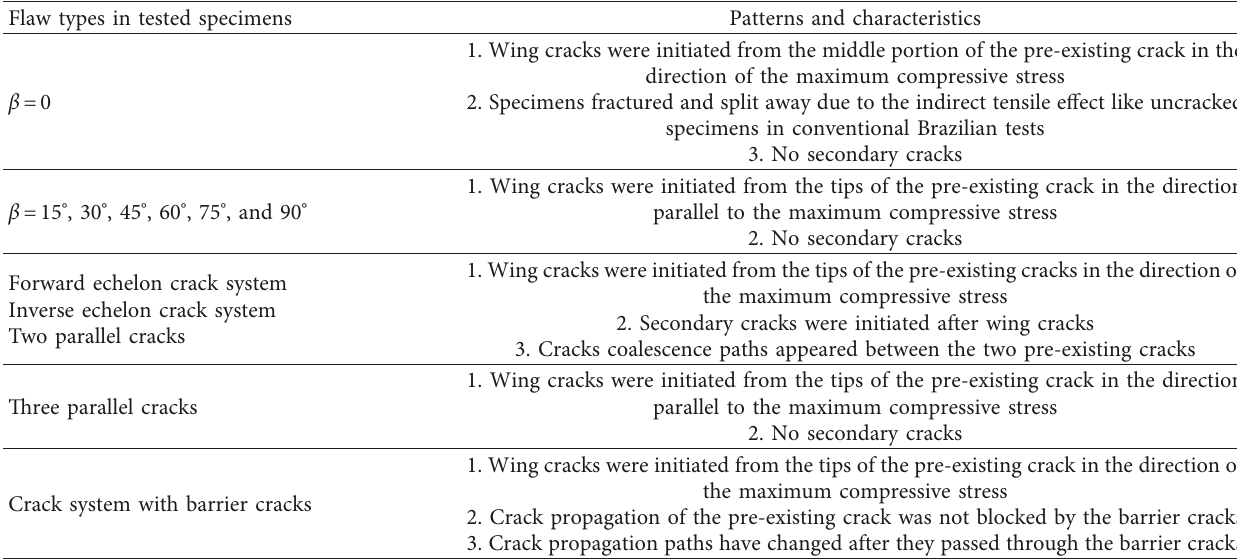
Table 2: Crack propagation patterns and characteristics in pre-cracked